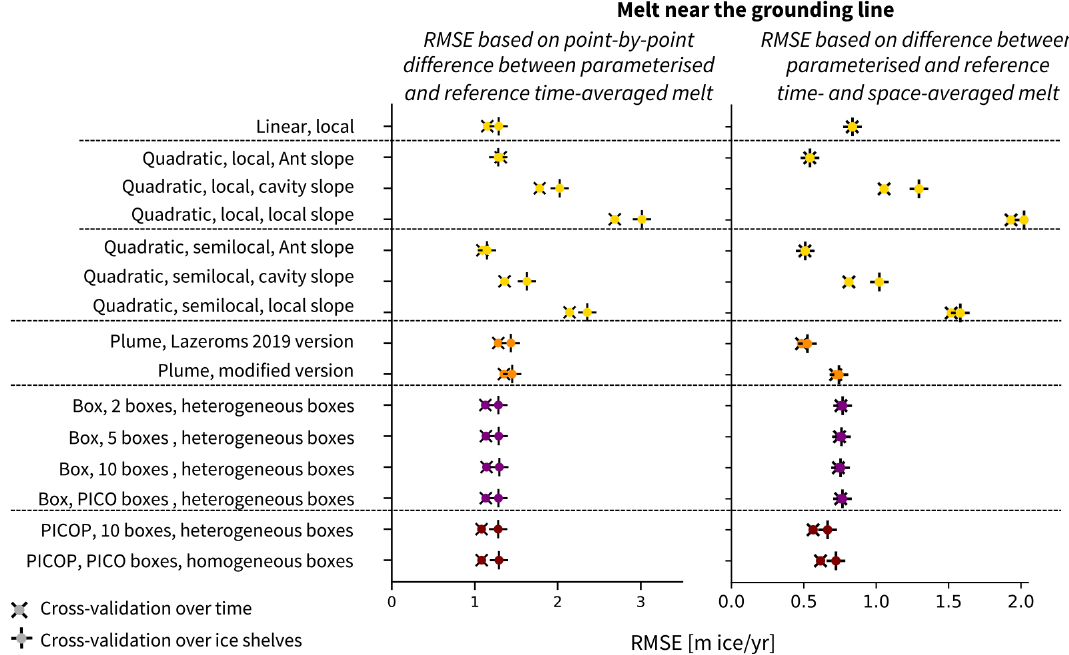
Figure F1. Comparison of two approaches to compute the RMSE of the melt rate near the grounding line (“near the grounding line” is defined as the first box in the five-box setup of the box parameterisation). Left: first, the melt rate near the grounding line is averaged over time, for the parameterised and reference melt rate and for each ensemble run separately. Second, we take the difference between parameterised and reference melt rate at each point and square it. Third, we average these squared differences over space and ensemble runs. Fourth, we take the square root of these averaged squared differences. Right: this is the method we use in the paper (same as shown in Fig. 7, right). First, the melt rate near the grounding line is averaged over time and space, for the parameterised and reference melt rate and for each ensemble run separately. Second, we take the difference between these averaged parameterised and reference melt rates and square it. Third, we average these squared differences over the ice shelves and ensemble runs. Fourth, we take the square root of these averaged squared differences. “Ant slope” stands for “Antarctic